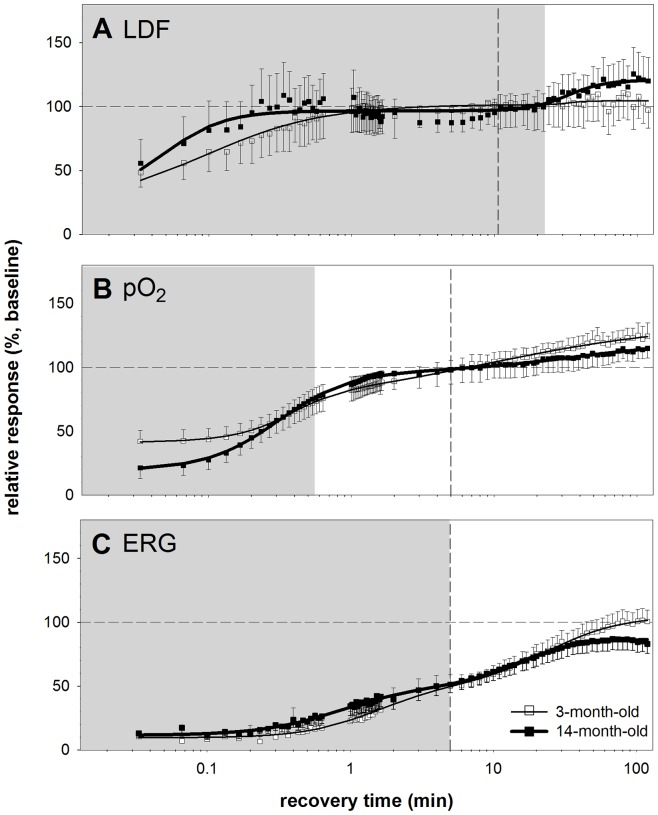
Recovery from IOP elevation.Relative recovery of LDF, pO2 and ERG as a function of time following IOP elevation in 3 (n = 14) versus 14 month (n = 16) old rats (mean ± SEM). Panel A shows the recovery of the LDF, while B. shows pO2 and C. shows the ERG recovery. A bi-logistic function was used to model the data. The shaded region denotes the duration of phase 1 recovery for the 3-month-old rats as given by the model and the vertical dashed line indicates the duration of phase 1 recovery for the 14-month-old group. Thin and thick solid lines are used to represent the bi-logistic fit to the 3- and 14-month-old animals respectively.